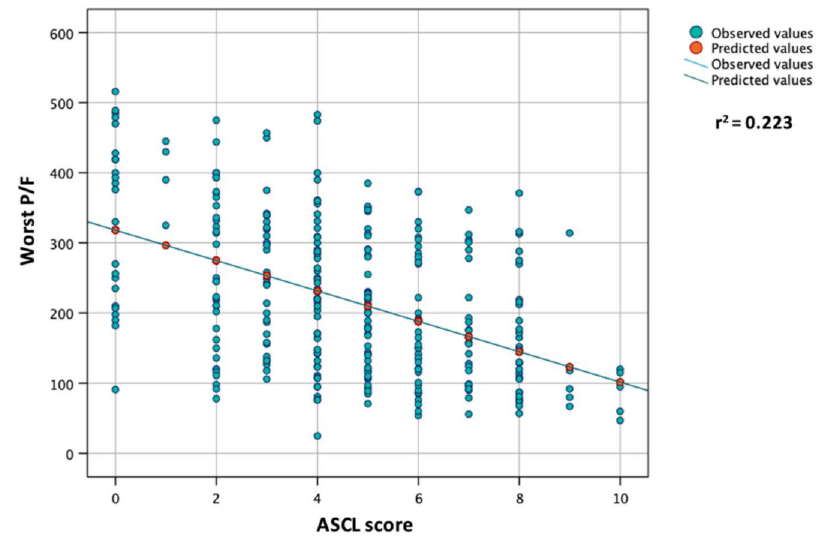
Figure 3. Linear regression analysis between worst P/F ratio during hospitalization (dependent) and ASCL score at admission.